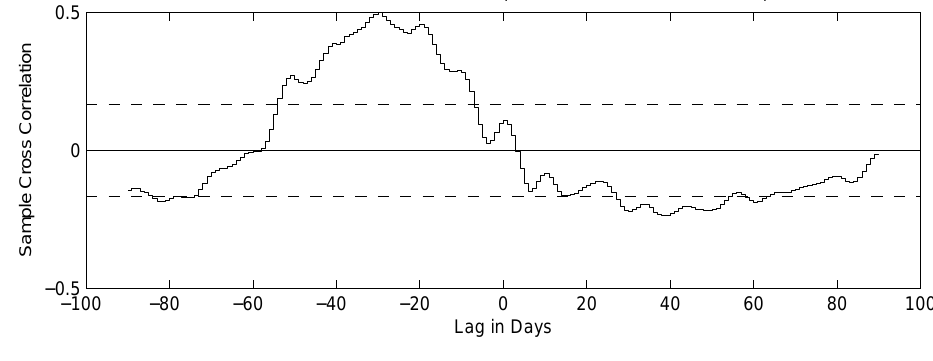
Fig. 10. Cross-correlation between NCEP temperatures at 10hPa and daily Z1 amplitudes. Both the NCEP temperatures and Z1 amplitudes were averaged over the latitudes between 70 ◦ S and 85 ◦ S. Dashed lines are the upper and lower 95% confidence bounds. seen in the wave spectra coincides with the peak in OH and O 2 temperature